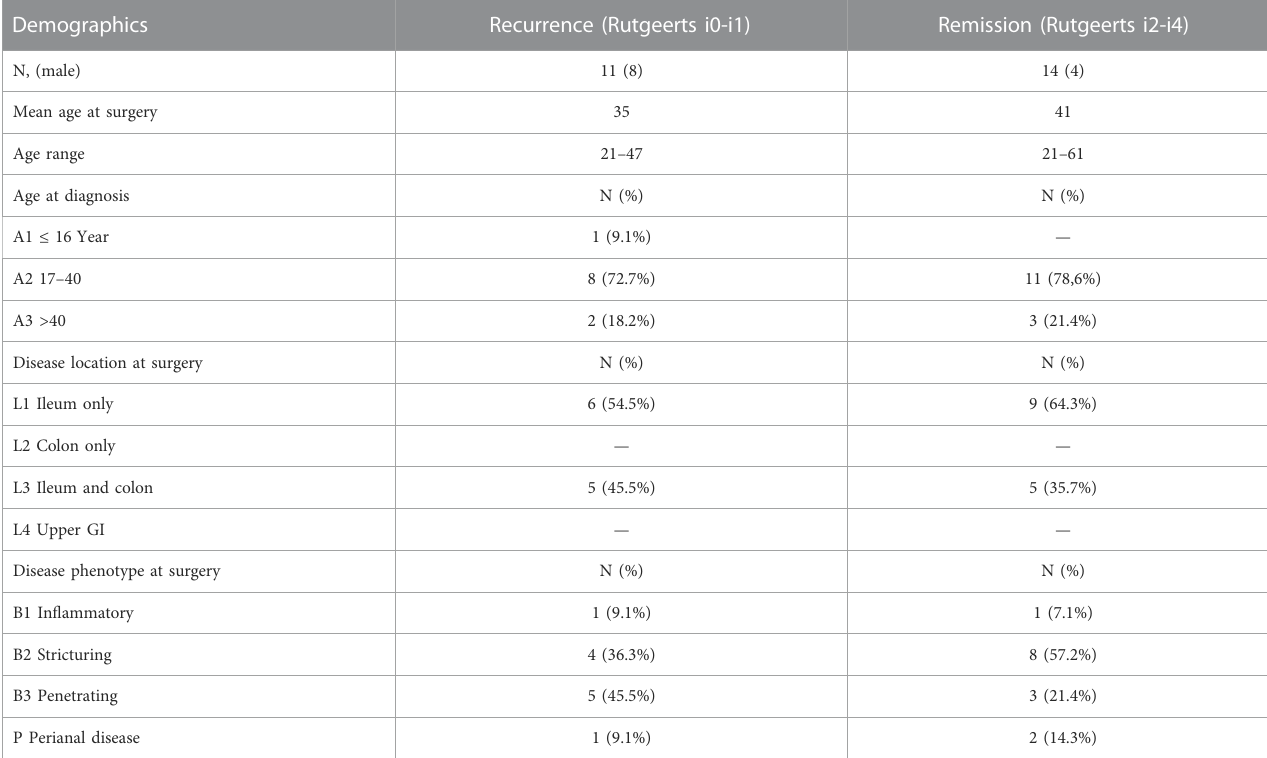
TABLE 1 Patient